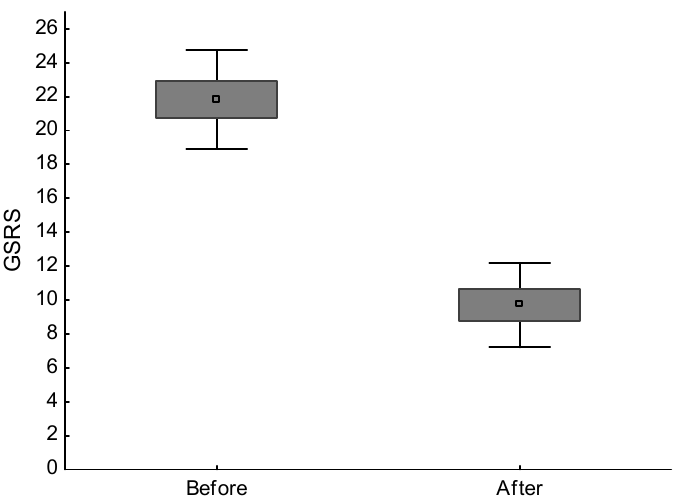
Figure 2. Average and standard deviations of gastrointestinal symptom rating scale (GSRS-points) in patients with diarrhea-predominant irritable bowel syndrome before and after nutritional treatment; difference is significant ( p < 0.001).